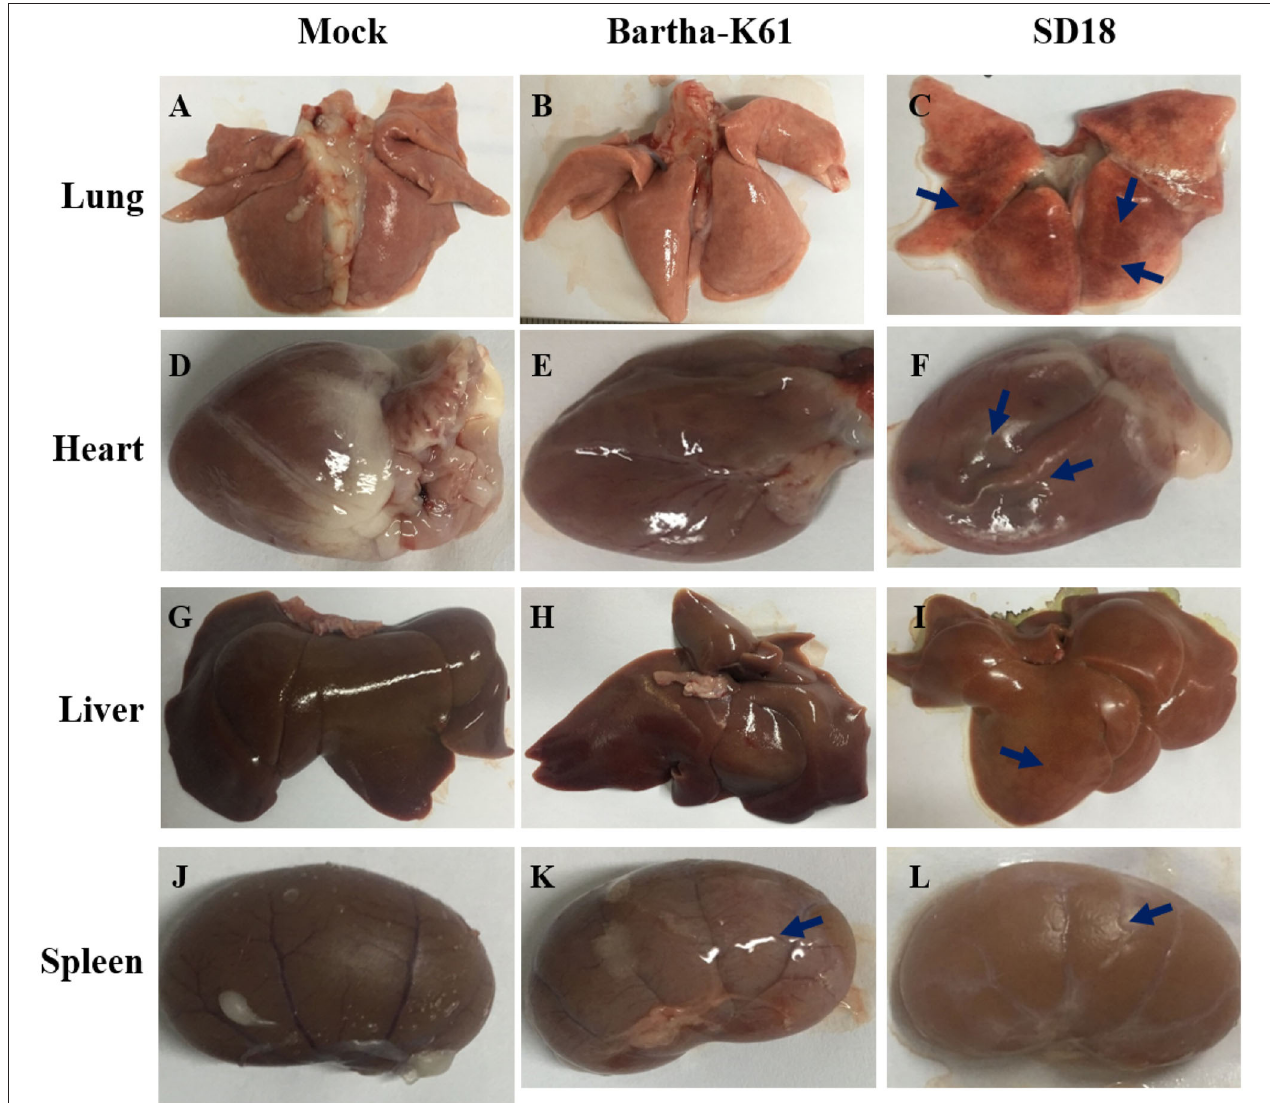
FIGURE 2 | Pathologic changes in PRV-infected cats. Cats that were 10 weeks old were infected with Bartha-K61, SD18, or PBS. All the cats were euthanized at 14 dpi. The autopsy was performed, and the gross abnormalities were recorded at necropsy. (A–C) The necropsy symptoms of the lung. (D–F) The necropsy symptoms of the heart. (G–I) The necropsy symptoms of the liver. (J–L) The necropsy symptoms of the